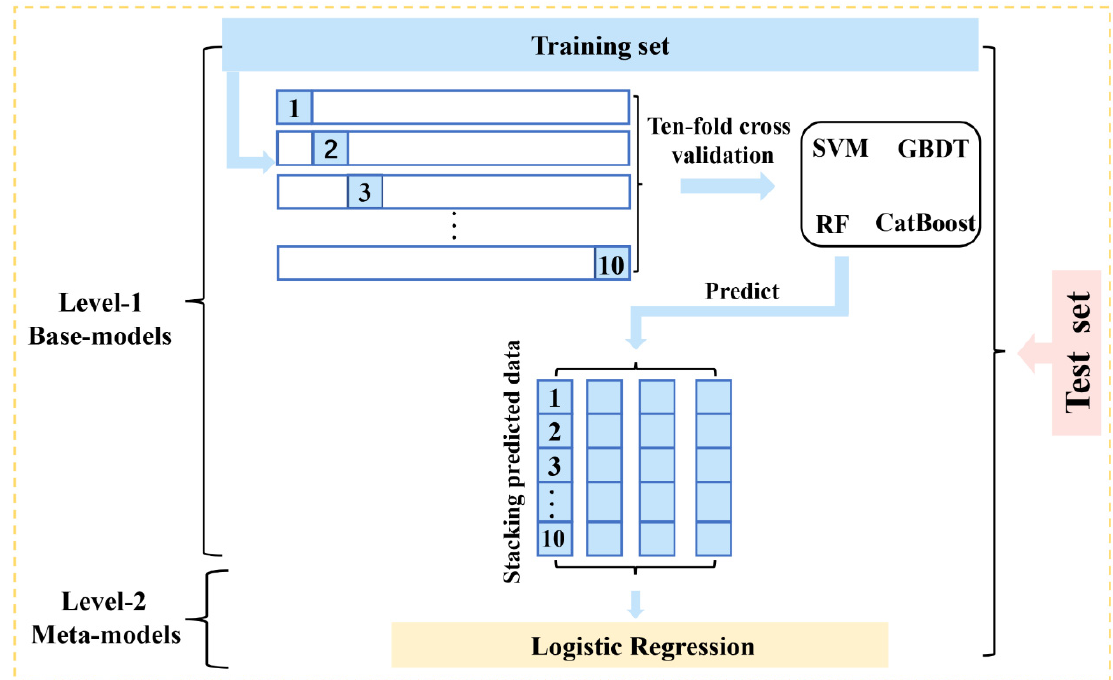
Figure 4. Construction framework of the super learner (the training and test sets are divided in a 7:3 ratio based on the samples. For the super leaner, the parameters of four base classifiers need to be defined and the parameters of logistic regression are default values).